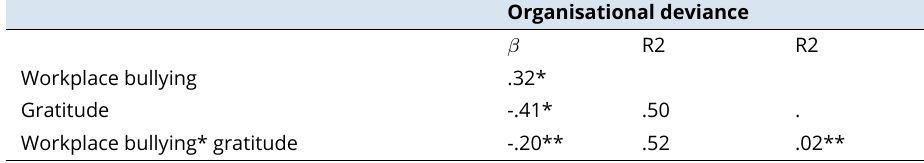
Results of Hierarchical Regression Analysis to test Gratitude as Moderator of WorkplaceBullying — Organisational Deviance Relationship (H2) Organisational deviance